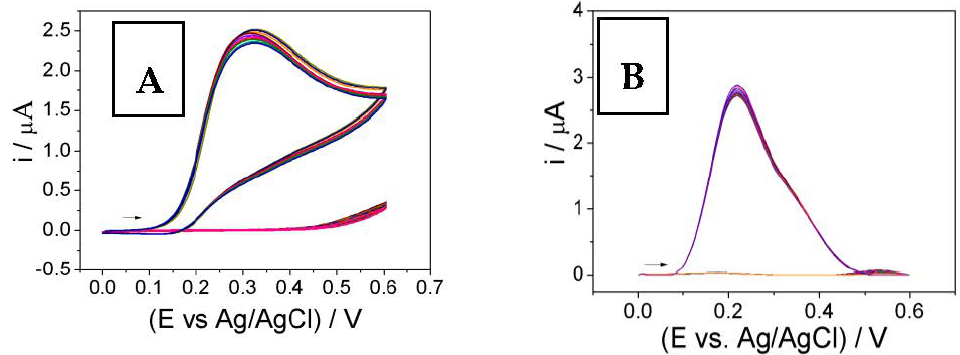
Figure 9. Cyclic voltammogram ( A ) and SWV ( B ) in the absence and presence of folate. The arrows indicate the direction of the scan